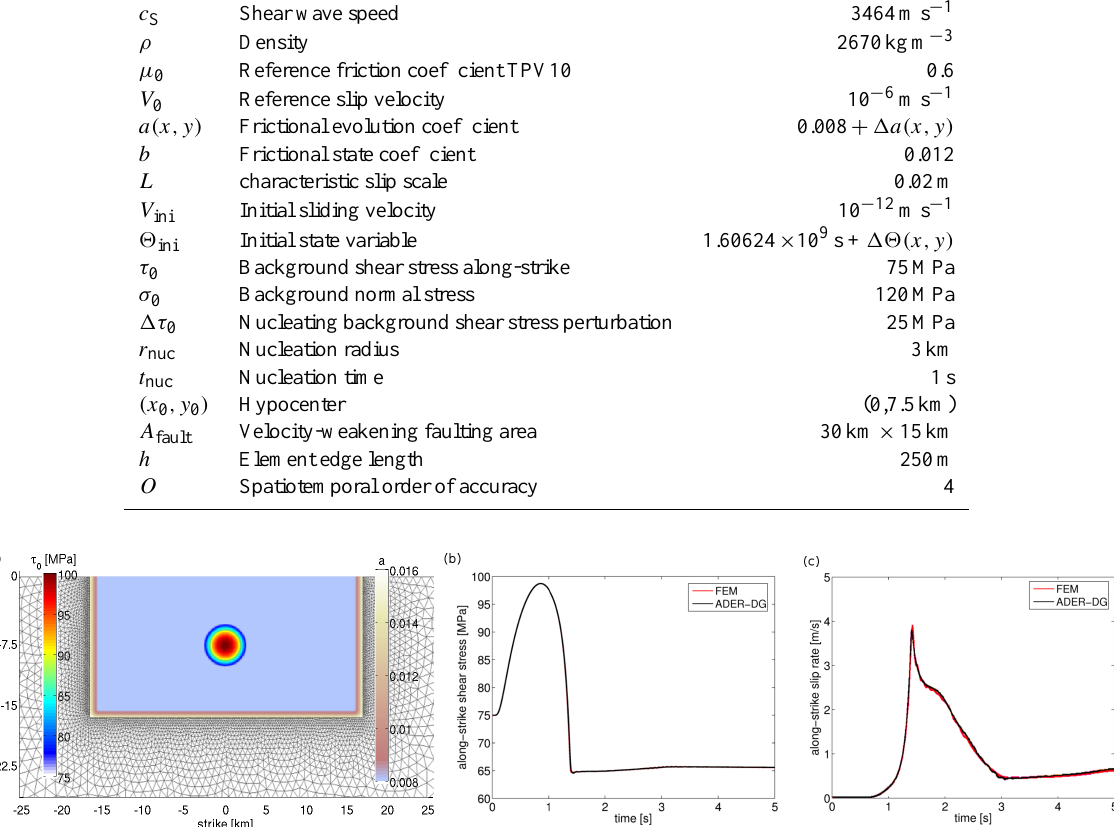
Fig. 15. (a) Nucleation and initial frictional parameters of SCEC test case TPV101. A velocity-weakening fault smoothly transitions to a surrounding velocity-strengthening material, by adapting the frictional parameter a . Nucleation is achieved by prescribing a space- and time-dependent circular stress perturbation. Along-strike (b) shear stress and (c) slip rate during nucleation at the hypocenter, located at 0km along-strike and 7 . 5km along-dip. The ADER-DG solution is shown in black, the FEM comparison solution in